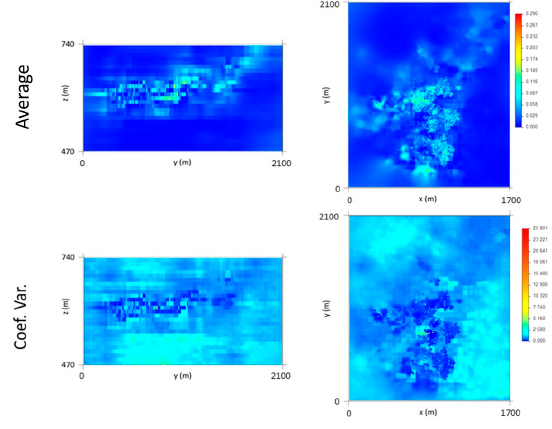
Figure 8. Results of the final vein proportion model (average and coefficient of variation (CV)): Px81 (left) and Pz75 (right).